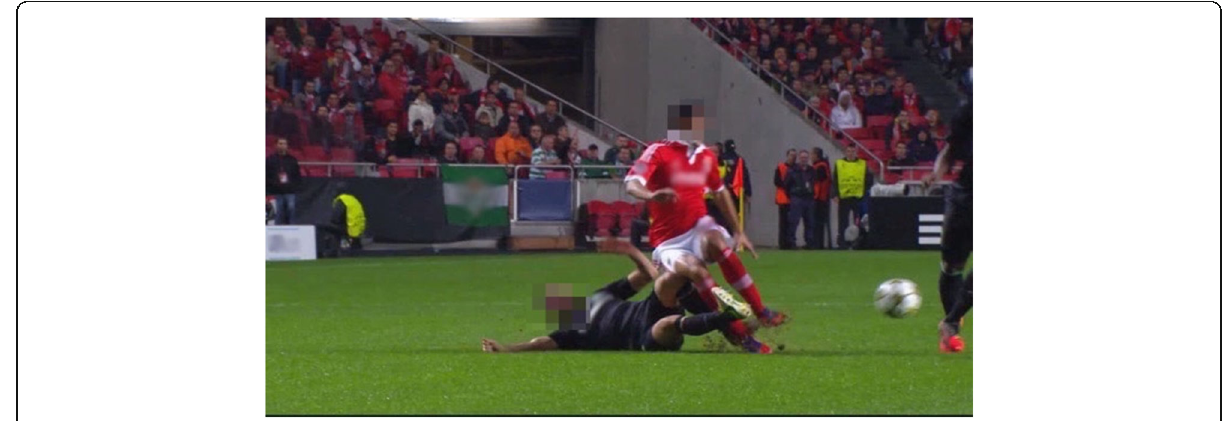
Fig. 1 Example of a foul-play situation for which the referees had to make a disciplinary decision (no card, yellow card, or red